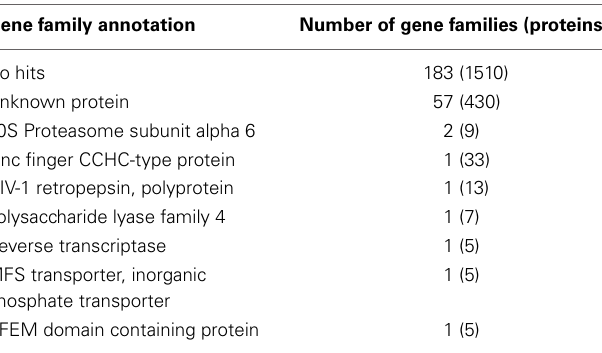
Table 3 | Cqf -specific duplicated gene families contain predominantly uncharacterized